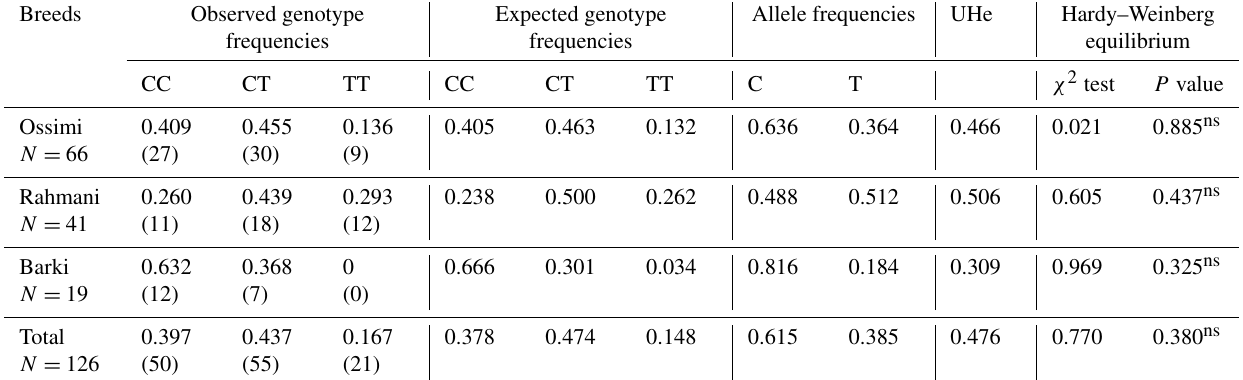
Table 1. Genotypes and allele frequencies of the MTNR1A SNP in Egyptian sheep breeds. Where N is the total number of animals in each breed; UHe is the unbiased expected heterozygosity; number in parentheses is the no. of genotype observed; ns represents non-significant. Breeds Observed genotype Expected genotype Allele frequencies Hardy–Weinberg frequencies frequencies equilibrium